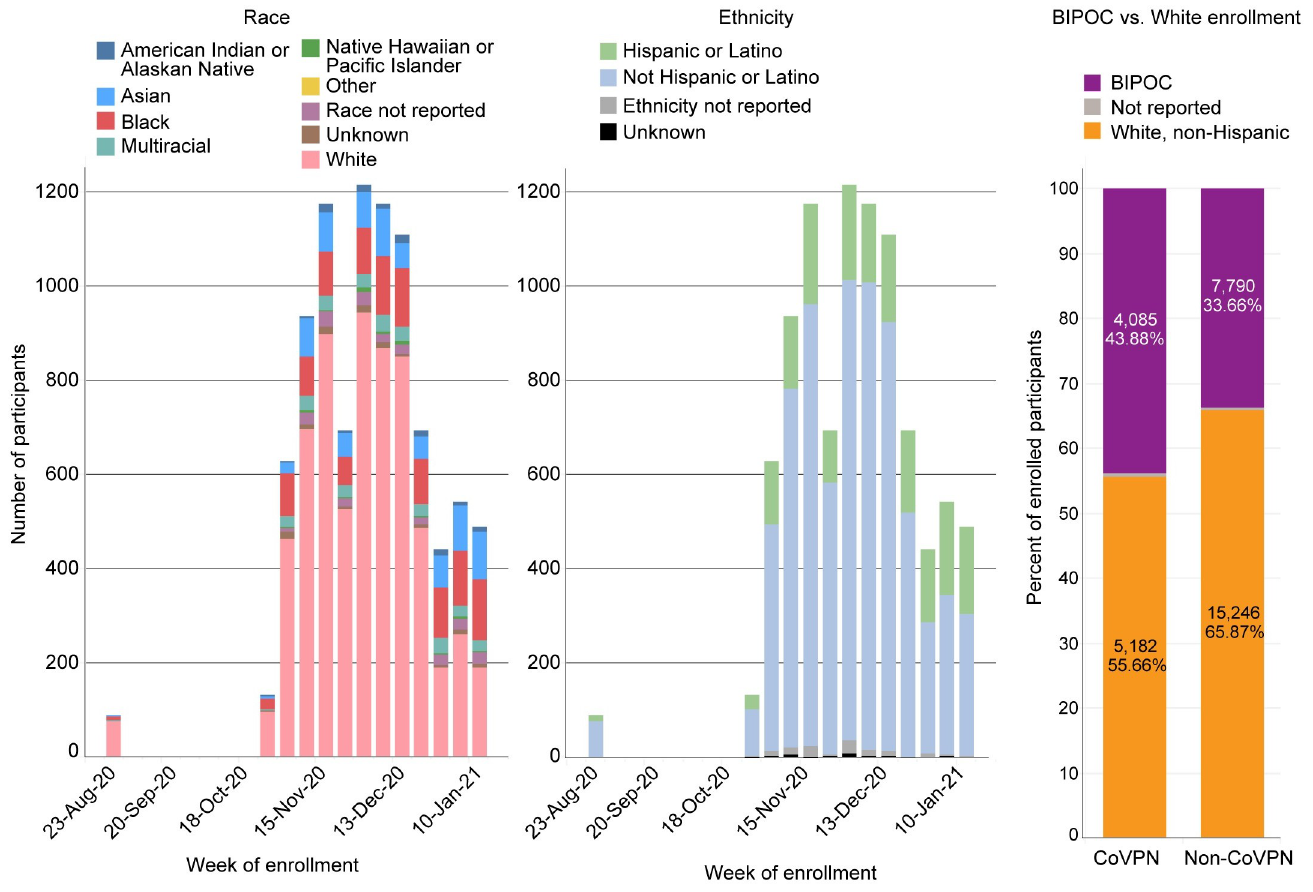
Fig 3. AstraZeneca study enrollment. (A) Counts reflect randomized participants.